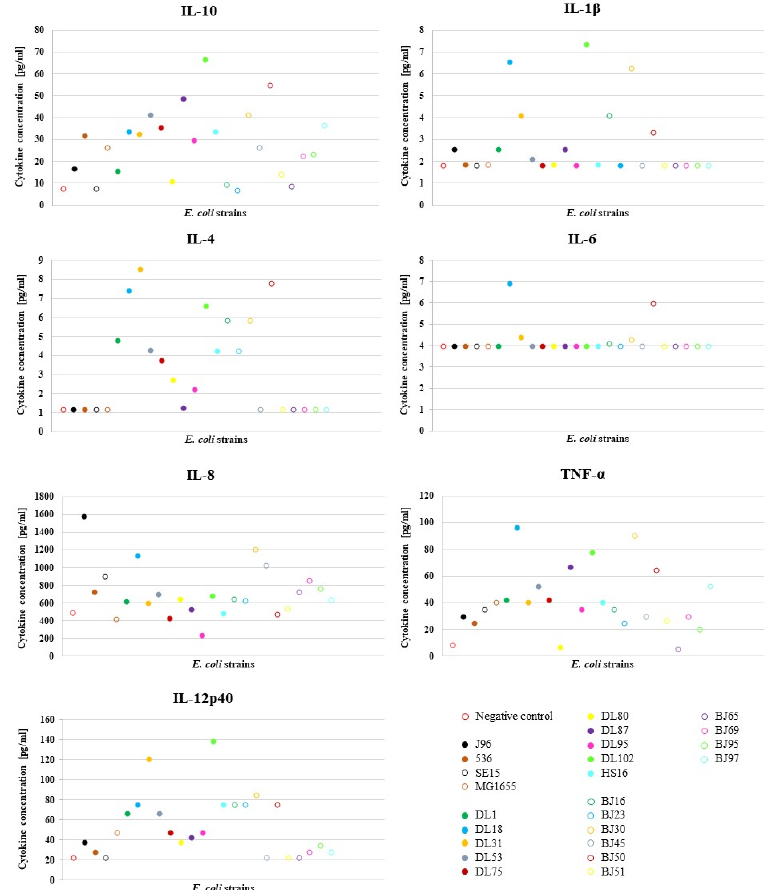
Figure 2. Average value of the cytokine concentrations produced by NPU cells in the E. coli infection assay. The experiment was performed in duplicates and the average value was calculated. Data for IFN- α and IFN- γ are not shown, as cytokine production of these two analytes was below the detection limit in all strains.